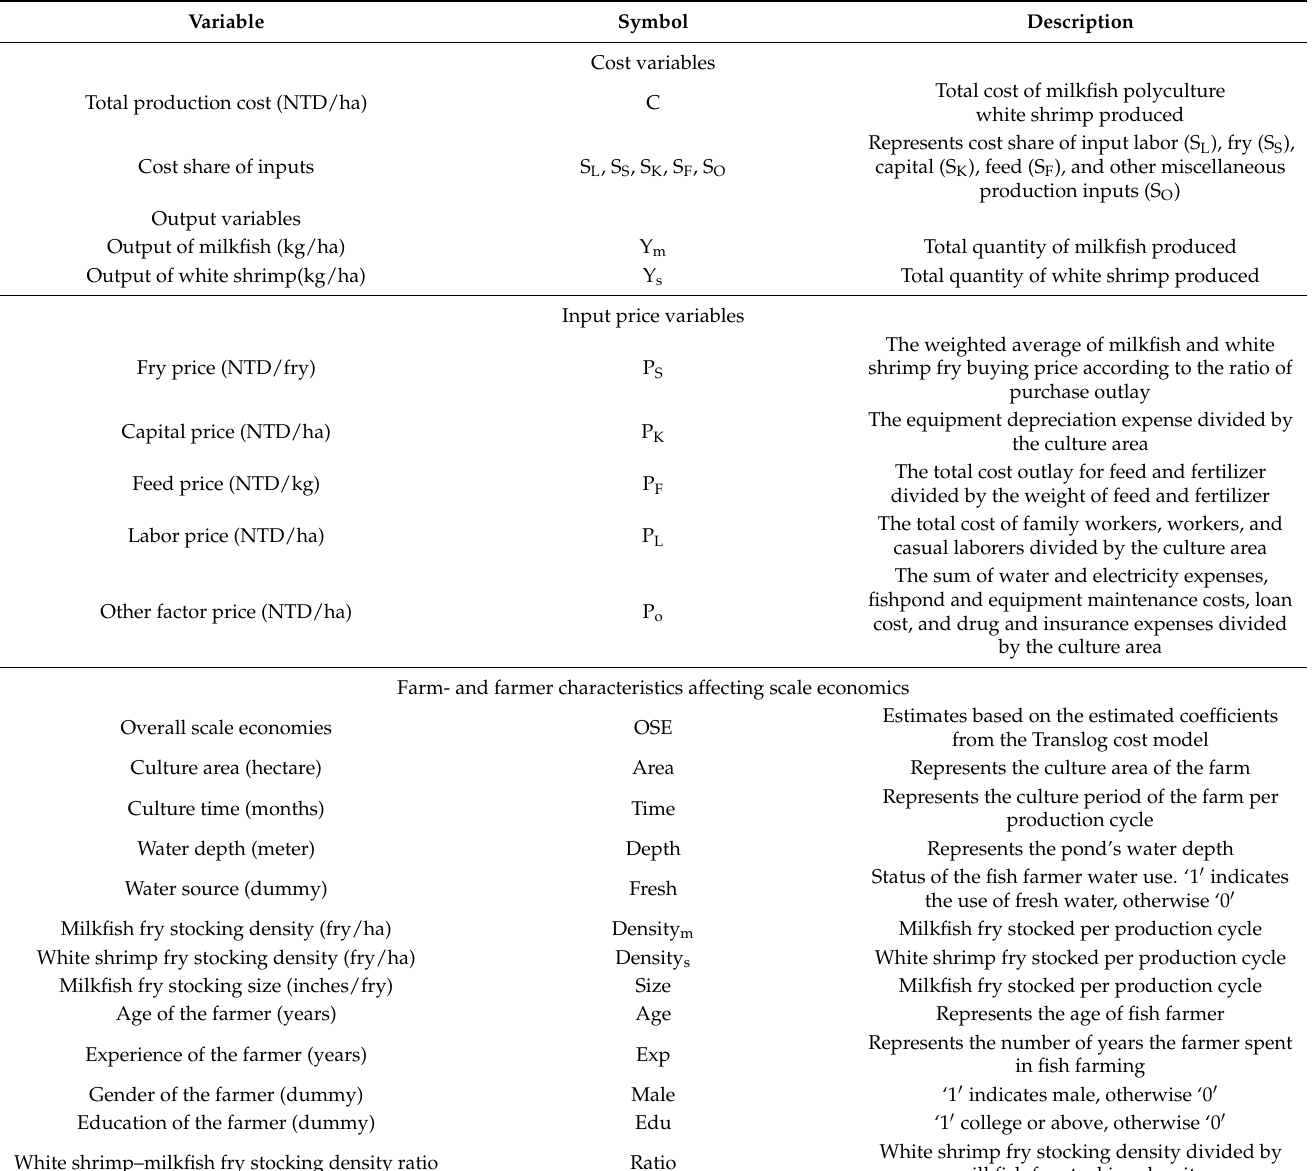
Table 1. Description of the variables in Translog cost and scale economies